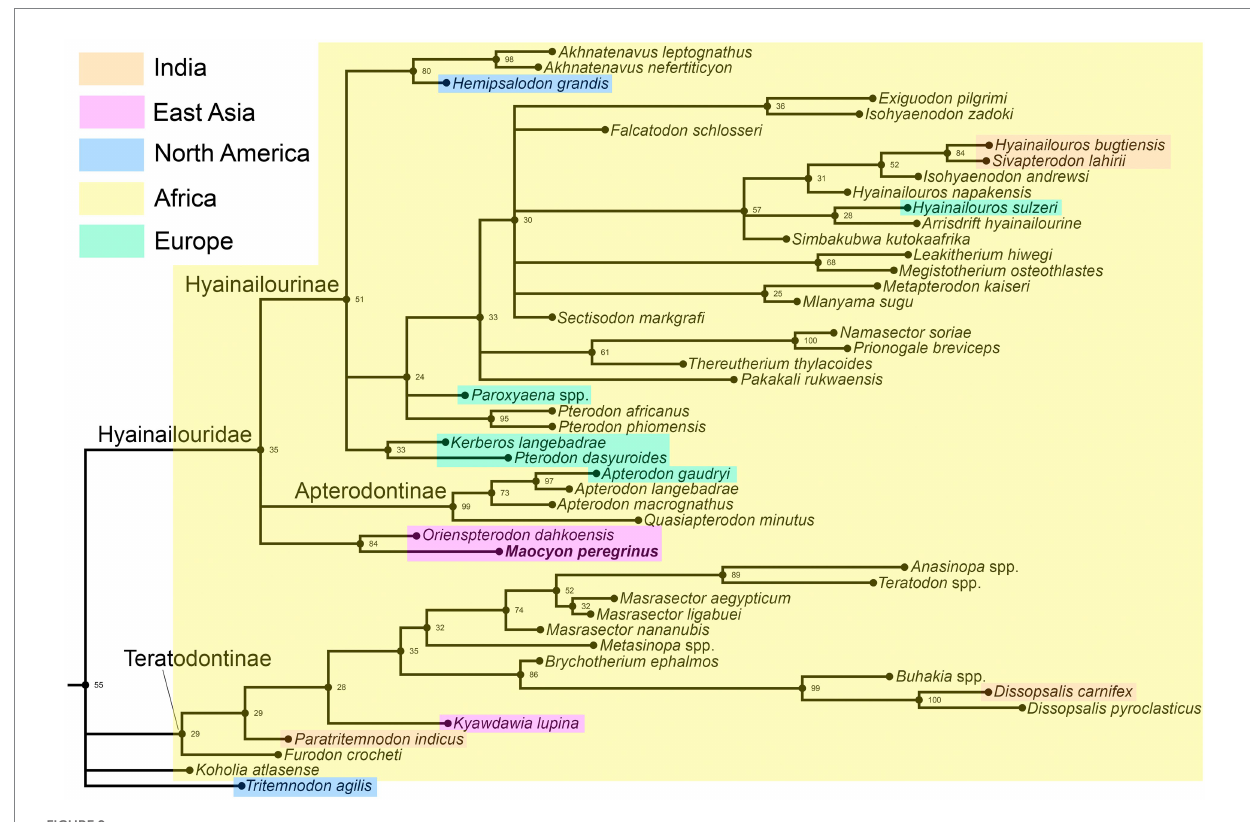
FIGURE 9 Segment of the “all compat” (majority rule plus compatible groups) consensus tree produced by tip-dating Bayesian analysis showing interrelationships within the Hyainailouroidea (see Supplementary material for the complete tree). Posterior probability (PP) shown at the relevant